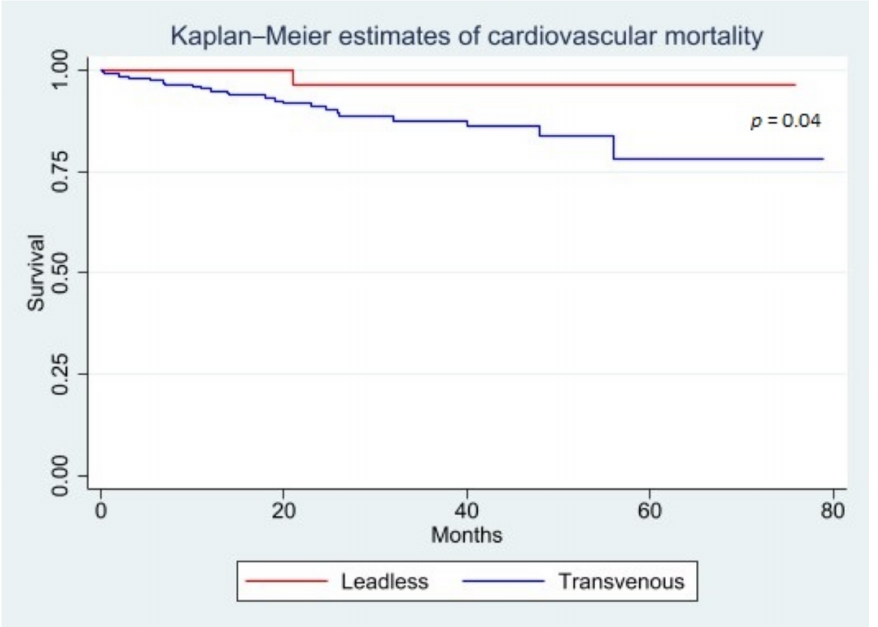
Figure 2. Kaplan–Meier estimates of all-cause and cardiovascular mortality in LL and TV PM recipients over the follow-up